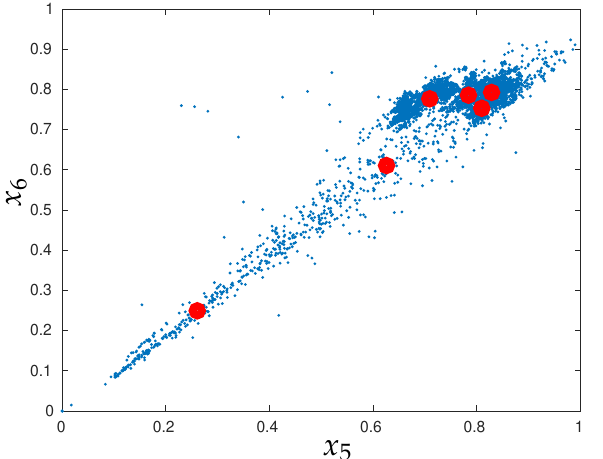
Figure 1. (Blue Dot): Scattered plot of variables x 5 , x 6 samples; (Red Circles) the projection of the mean values (cid:126) µ k calculated by EM algorithm.